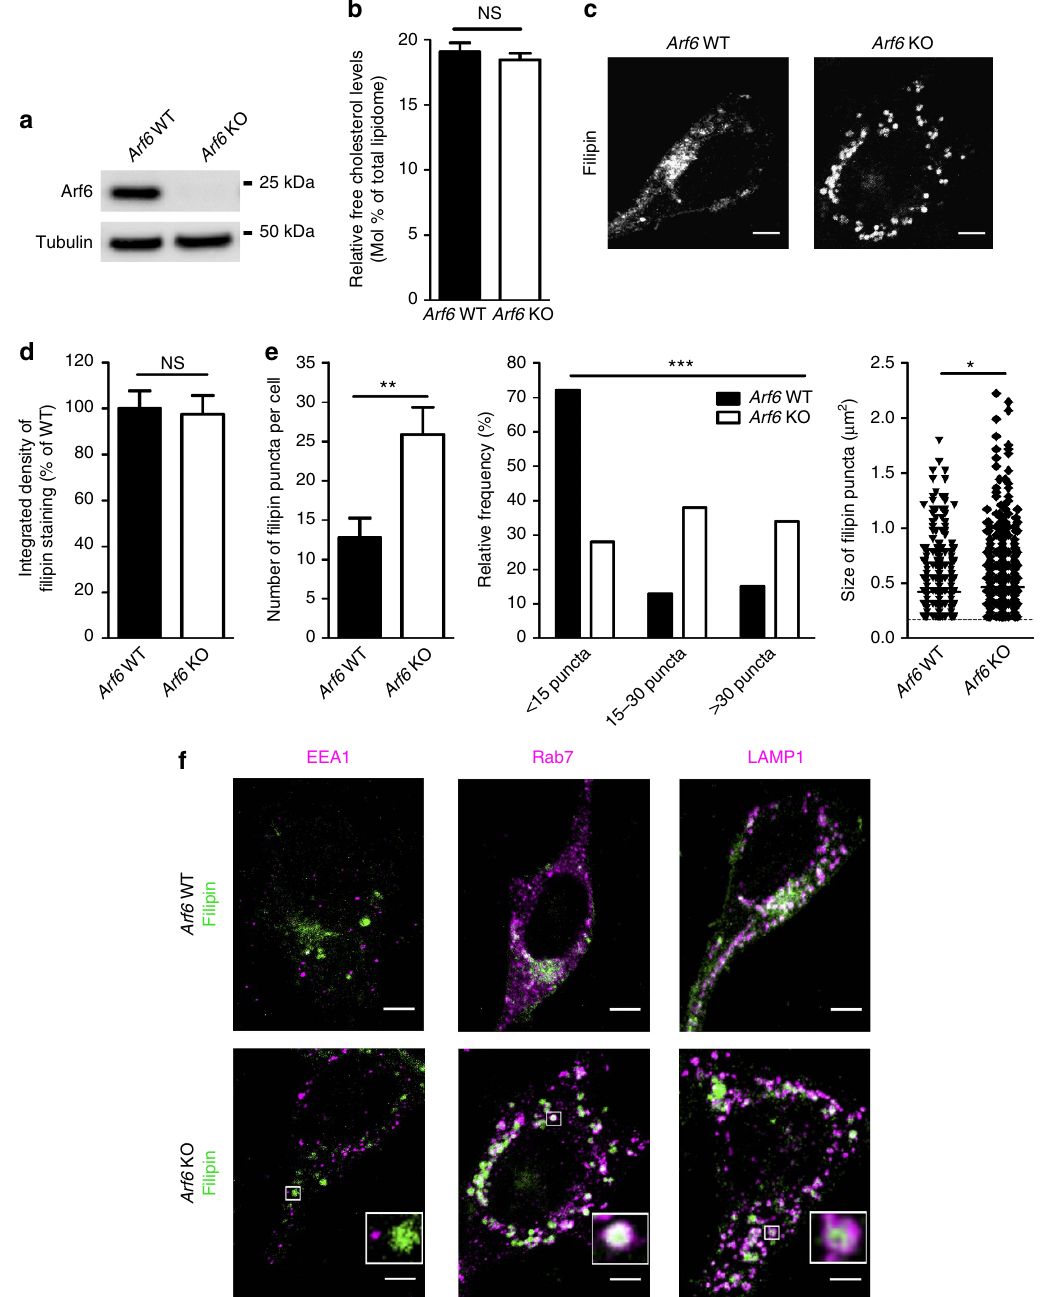
Figure 1 | Cholesterol is redistributed to late endosomes/lysosomes in Arf6 KO MEFs. ( a ) Western blot analysis of endogenous Arf6 levels in Arf6 Flox/Flox ; Cre-ER MEFs treated with DMSO ( Arf6 WT) or tamoxifen ( Arf6 KO). Tubulin was used as an equal loading marker. ( b ) Cholesterol levels measured by LC–MS were similar in Arf6 WT (19.1 ± 0.7 molar % of total lipidome, ± indicates s.e.m., n ¼ 11) and KO cells (18.5 ± 0.5 molar % of total lipidome, n ¼ 12). NS denotes P 4 0.05 in Student’s t -test. ( c ) Representative confocal images of Arf6 WTand KO MEFs stained with filipin. Scale bar, 5 m m. ( d ) Normalized integrated densities of filipin staining were similar in Arf6 WT (100 ± 8%, ± indicates s.e.m., n ¼ 32 cells from three experiments) and Arf6 KO cells (98 ± 8%, n ¼ 42 cells from four experiments). NS denotes P 4 0.05 in Student’s t -test. ( e ) Quantification of filipin puncta in Arf6 WTand KO cells. Left panel, number of puncta per cell in Arf6 WT (13 ± 2 puncta per cell, ± indicates s.e.m., n ¼ 39 cells from 3 experiments) and Arf6 KO cells (26 ± 3 puncta per cell, n ¼ 29 cells from 3 experiments). ** P o 0.01 in Student’s t -test. Middle panel, frequency distribution of the number of filipin puncta per cell. *** P o 0.001 in w 2 -test. Right panel, scatter dot blot of the size of filipin puncta in Arf6 WT (0.42 ± 0.01 m m 2 , ± indicates s.e.m., 498 puncta from 39 cells) and KO cells (0.47 ± 0.01 m m 2 , 749 puncta from 29 cells). * P o 0.05 in Mann–Whitney test. ( f ) Representative immunostainings for EEA1, Rab7 or LAMP1 (magenta) of Arf6 WT or KO cells labelled with filipin (green). Scale bar, 5 m m. NS, not significant. NATURE COMMUNICATIONS|7:11919|DOI: